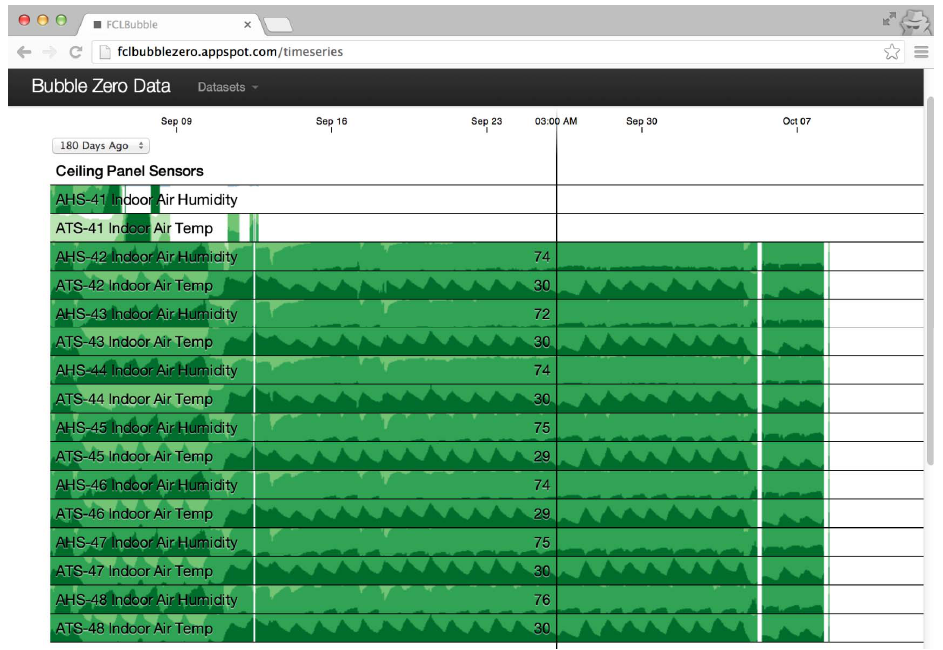
Figure 7. BubbleZERO dashboard